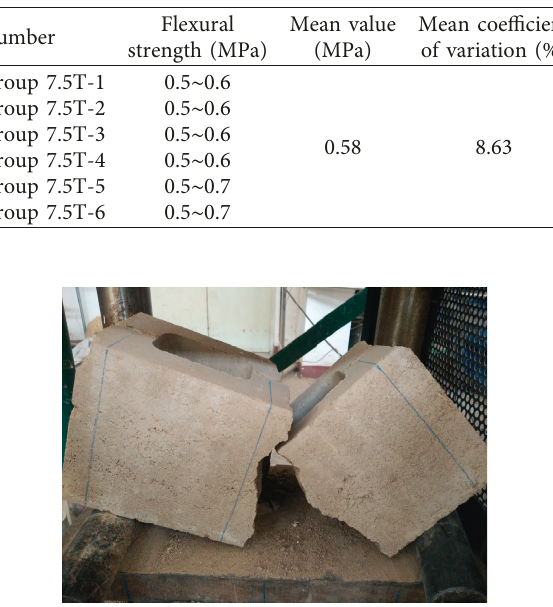
Figure 7: Typical failure mode for a single HCCSEB tested under three-point